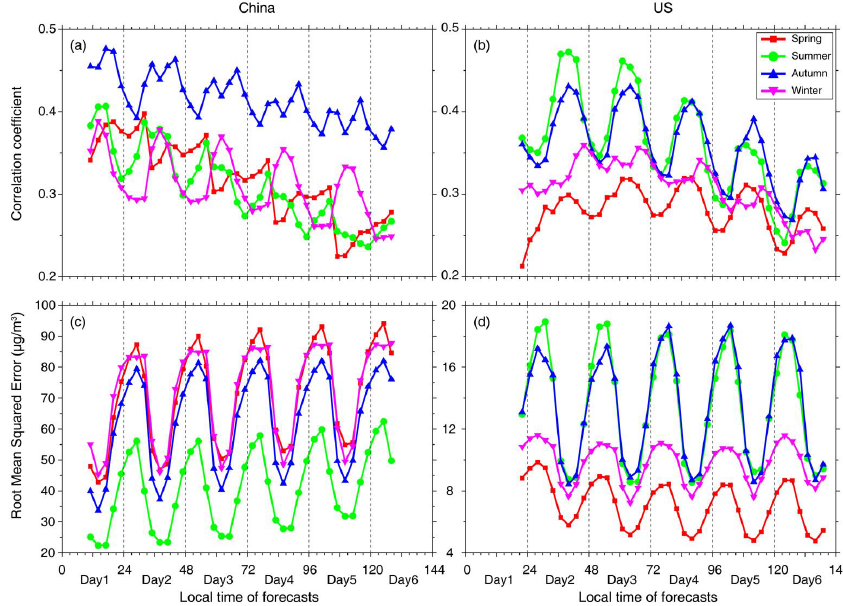
Figure 4. Temporal evolutions of seasonal mean correlation coe ffi cient ( a , b ) and RMSE ( c , d ) at each forecasting time step in China and